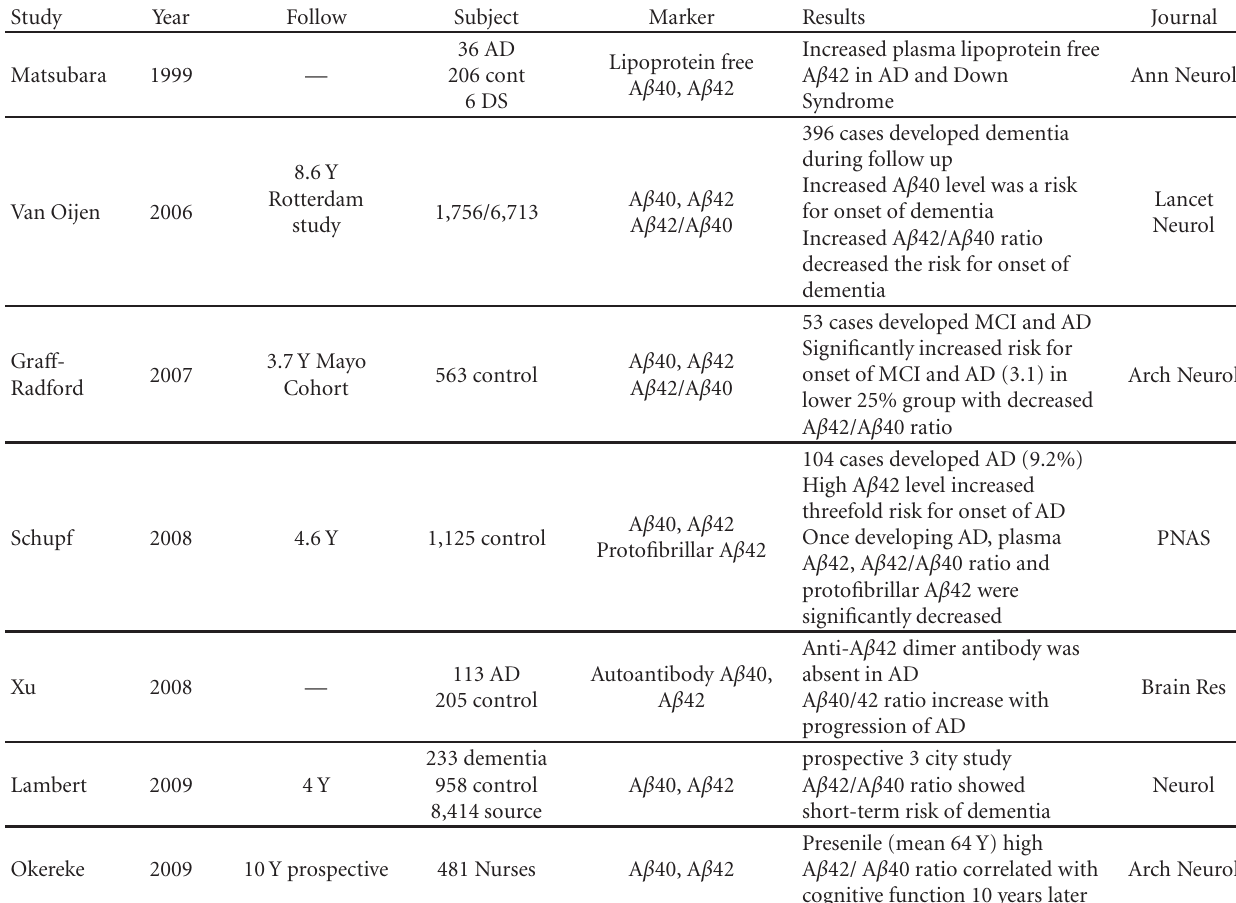
Table 3: Major studies of plasma A β 40 and A β